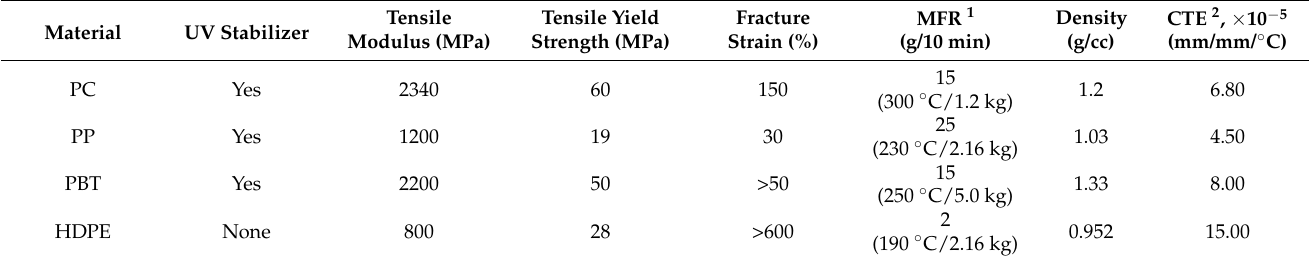
Table 1. Basic information on four